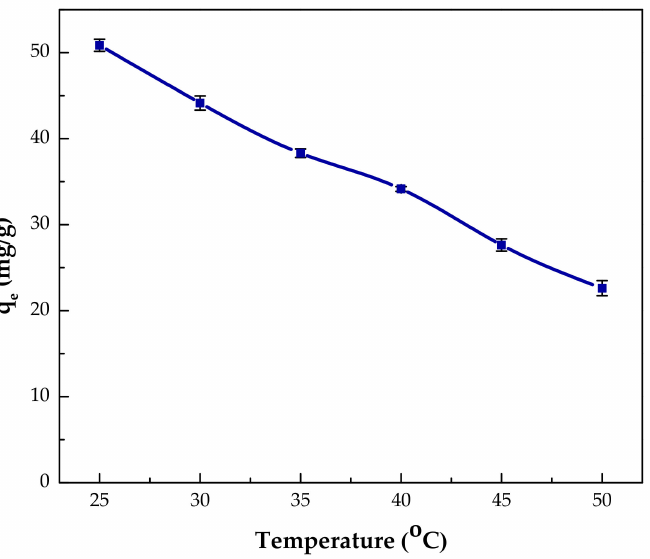
Figure 12. Effect of temperature on phenol adsorption capacity of IL–agar–alginate beads ( Ci = 150 mg/L, pH of 2, 150 rpm, 2 h and beads dosage = 1 mg/mL). Table 2. Kinetic parameters for the adsorption of phenol onto the IL–agar–alginate beads at 25 ◦ C. Kinetic